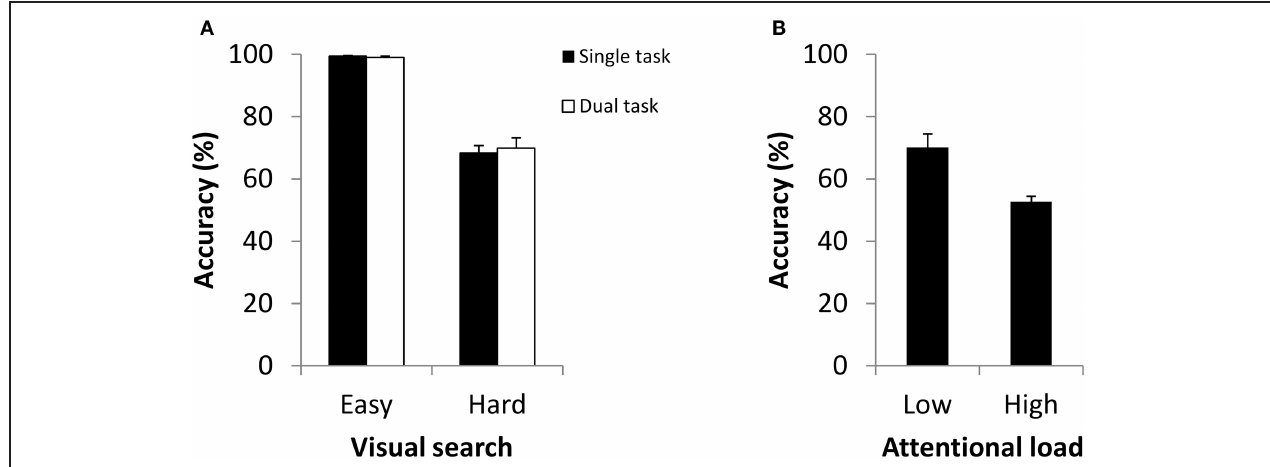
FIGURE 3 | (A) Accuracy for visual search for single and dual tasks as a function of search type in Experiment 2. (B) Partial-report accuracy in dual tasks as a function of attentional load in Experiment